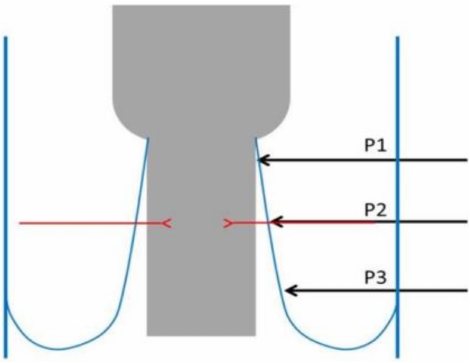
Figure 12. Anatomic regions where NRL nerve injuries of usually occur.